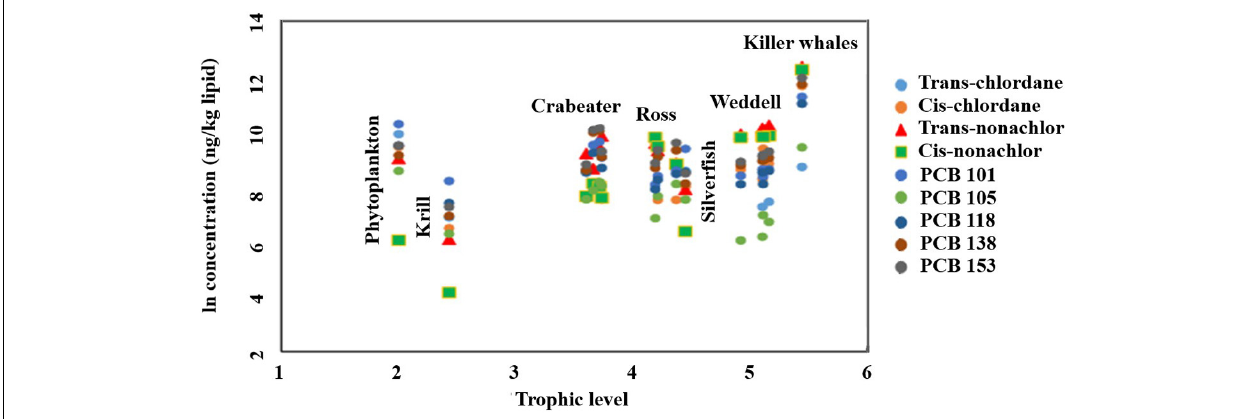
FIGURE 5 | Ln concentration-trophic level relationship for average values of chlordanes and PCB congeners in the trophic food web of western Antarctica (Amundsen and Ross Sea).